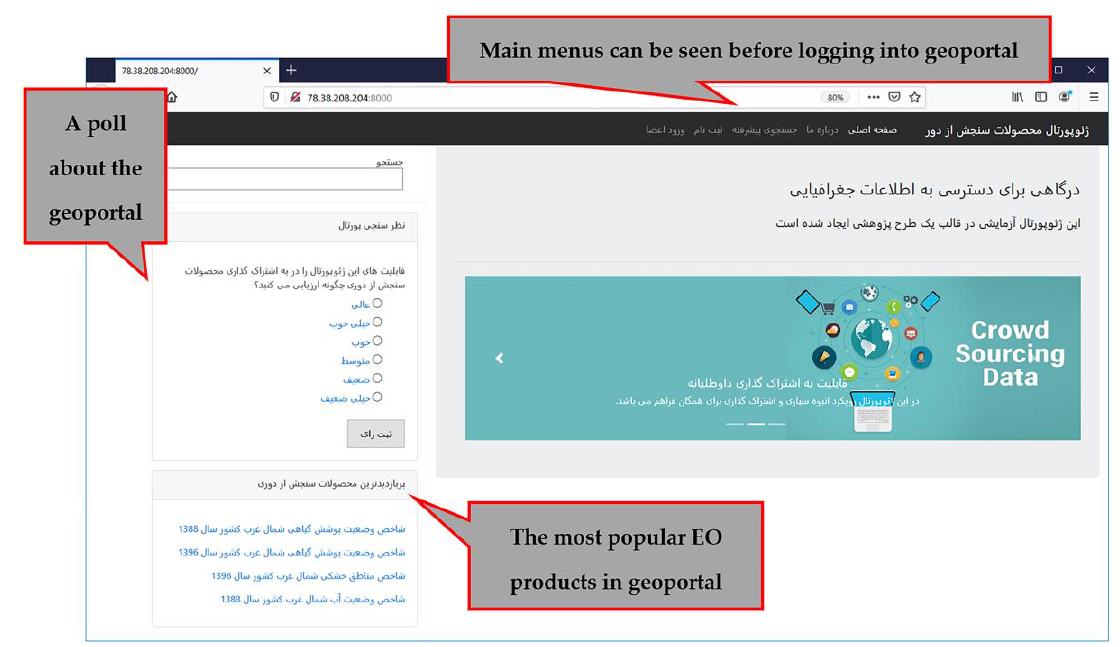
Figure 7. The home page of the OCCGEOP geoportal and menus.